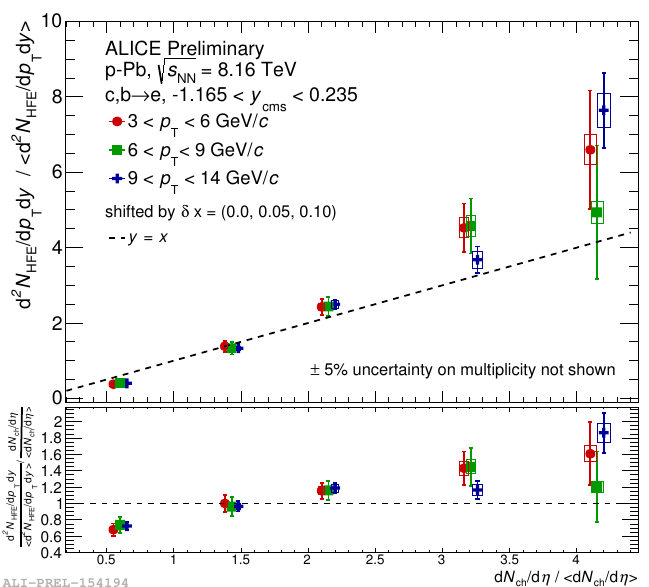
Figure 5. Relative yield of HFE as a function of relative charged-particle multiplicity in different p T intervals measured in p–Pb collisions at